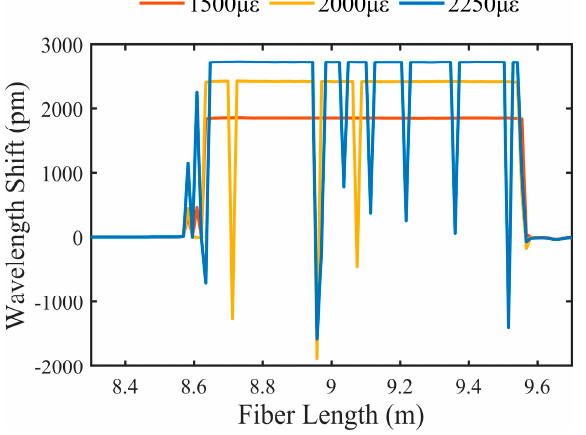
Figure 1. Wavelength shift calculated by cross − correlation algorithm at strains of 1500, 2000, and 2250 µ ε .